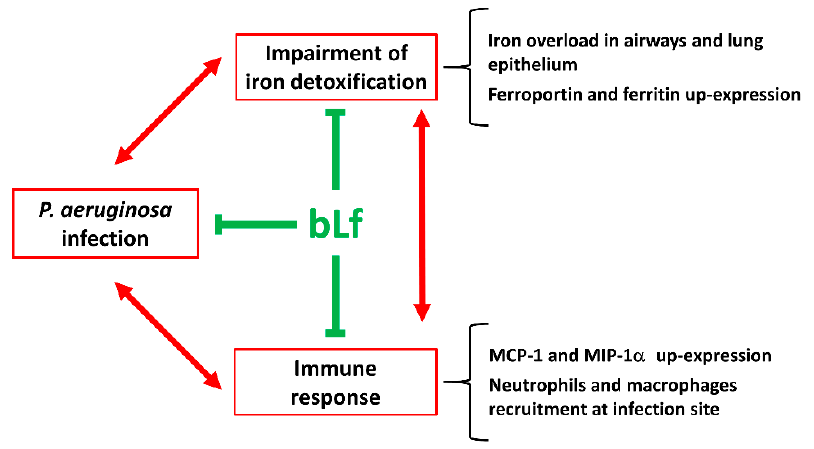
Figure 6. Summary diagram on bLf multi-targeting activities (green T bars) counteracting the unsafe vicious cycle established by infection, inflammation and iron dysbalance (red arrows) in CF mice suffering from Pseudomonas aeruginosa chronic lung infection.